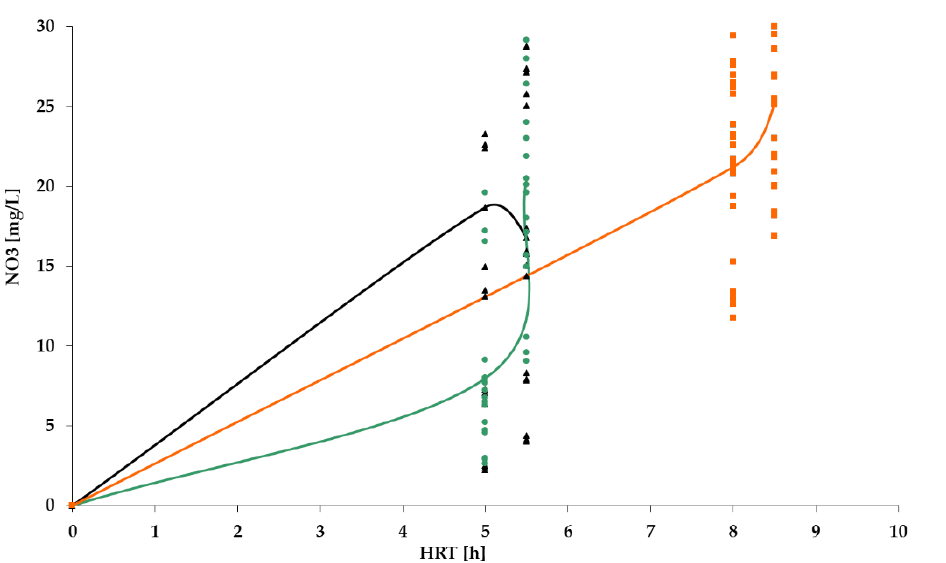
Figure 20. NO 2 : stage 1 (black); stage 2 (green); stage 3 (orange).